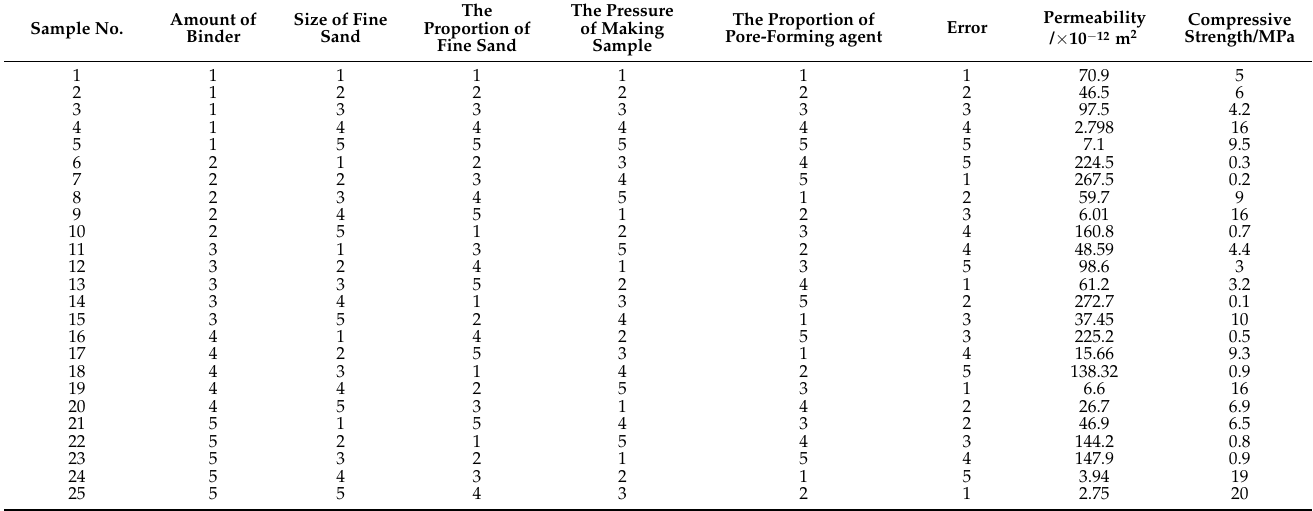
Table 2. Experimental results of the orthogonal